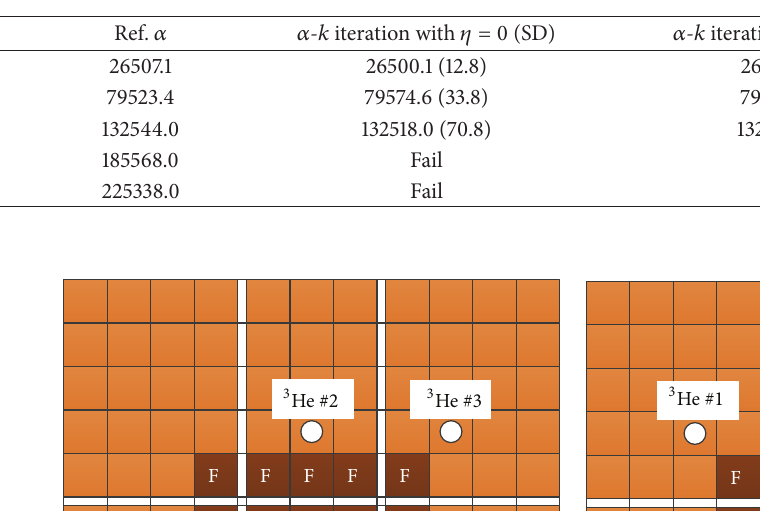
Table 2: Comparisons of 𝛼 estimates for the infinite homogeneous problem.